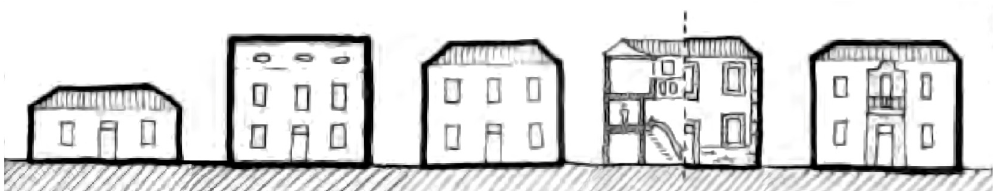
Figure 4. Typologies of houses in San Cristóbal de La Laguna (extracted from [29]). From left to right: terrera, granero, sobradada, comercial, and armera.